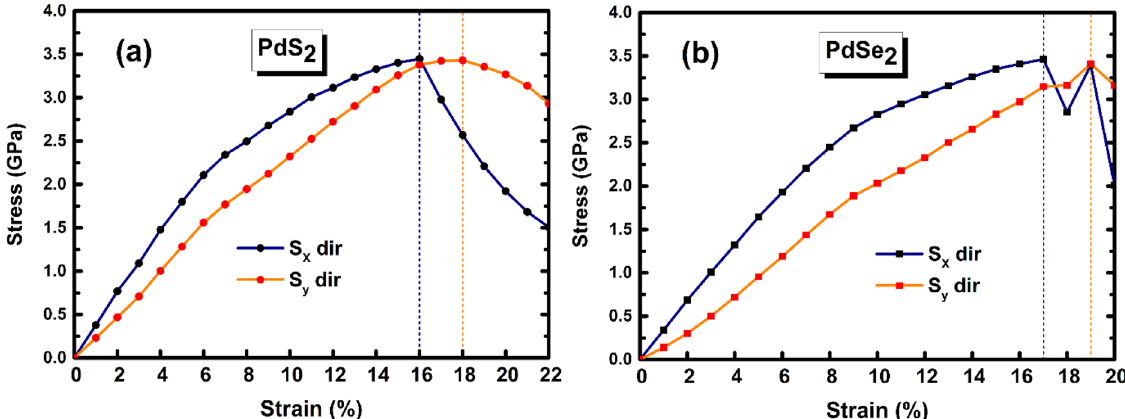
Figure 2. The stress (GPa) vs strain ( % ) curve under tensile strain. ( a ) For penta-PdS 2 and ( b ) For penta- PdSe 2